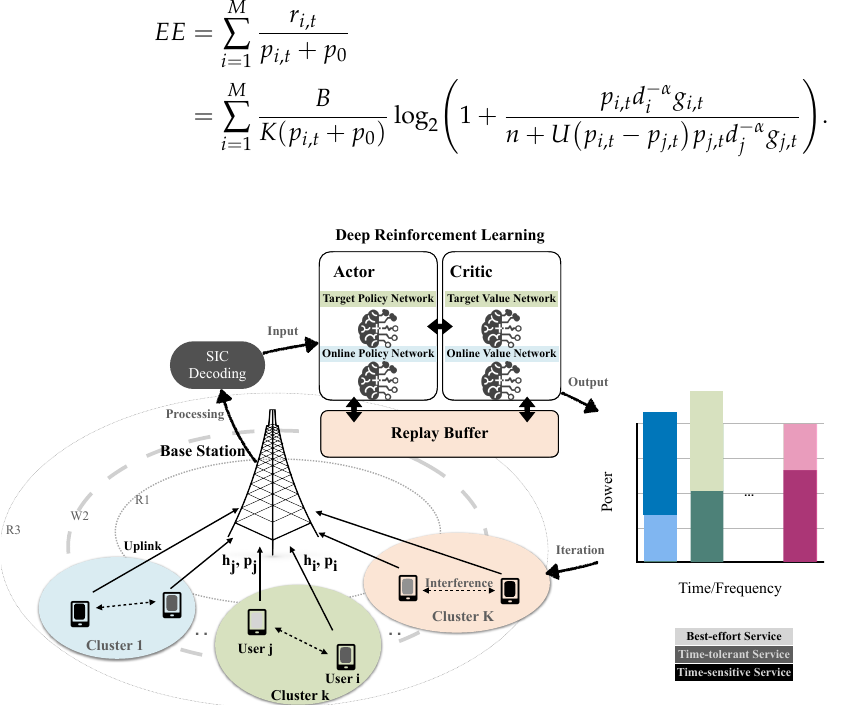
Figure 1. Multiuser with hierarchical QoS in Uplink NOMA network and Reinforcement Learning for power